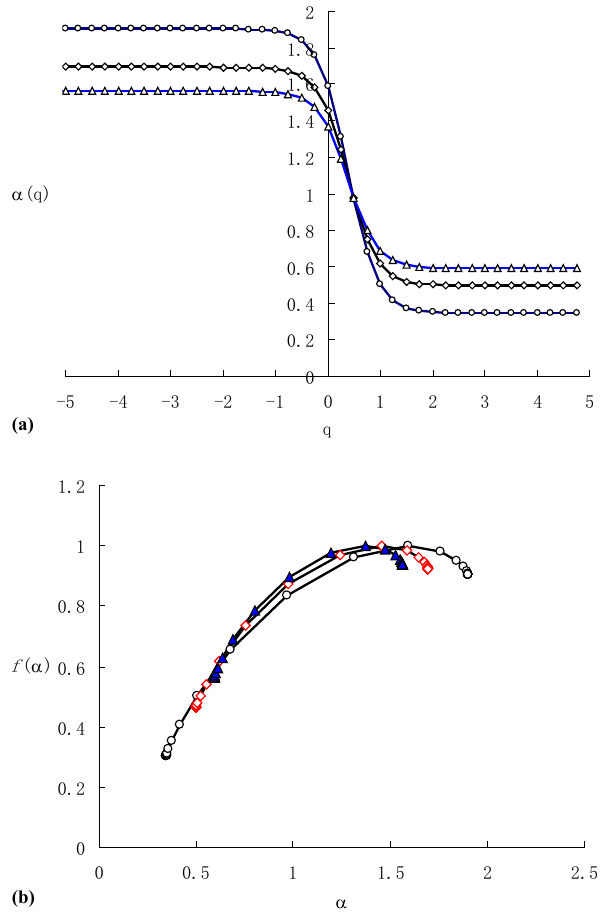
Fig. 2. (a) Singularity functions α(q) obtained from asymmetrical de Wijs model values of d 1 = 0 . 1 and d 2 = 0 . 9 and different parti- tions m 1 = 2, m 2 = 6, and h = 8 (dots), m 1 = 4, m 2 = 12, h = 16 (diamonds) and m 1 = 8, m 2 = 24, and h = 32 (triangles), respec- tively. Ranges of q value are similar for all models. (b) The results of spectra function f (α) for different partitions with value d 1 = 0 . 1 and d 2 = 0 .